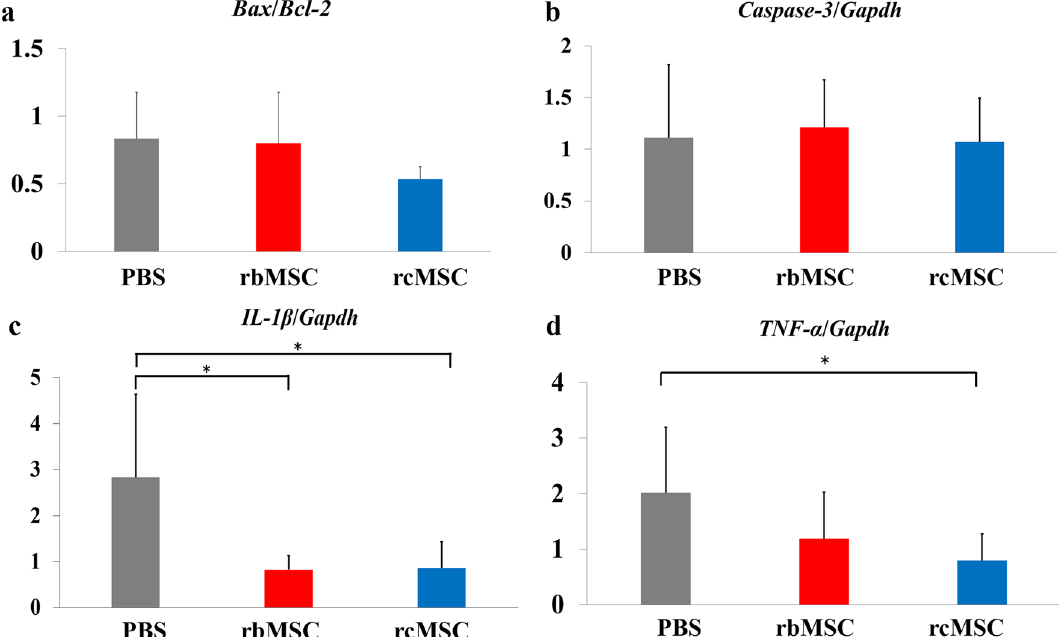
Figure 5. mRNA expression levels in the spinal cord lesion site. Relative mRNA levels of Bax/Bcl2 ( a ), Casp3/Gapdh ( b ), Il1B/Gapdh ( c ), and Tnfa/Gapdh ( d ). Data are presented as the mean ± SD of